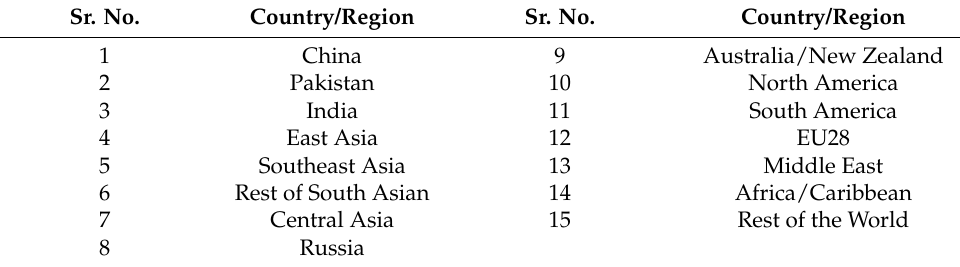
Table A2. GTAP Regional Aggregation. Sr. No. Country/Region Sr.